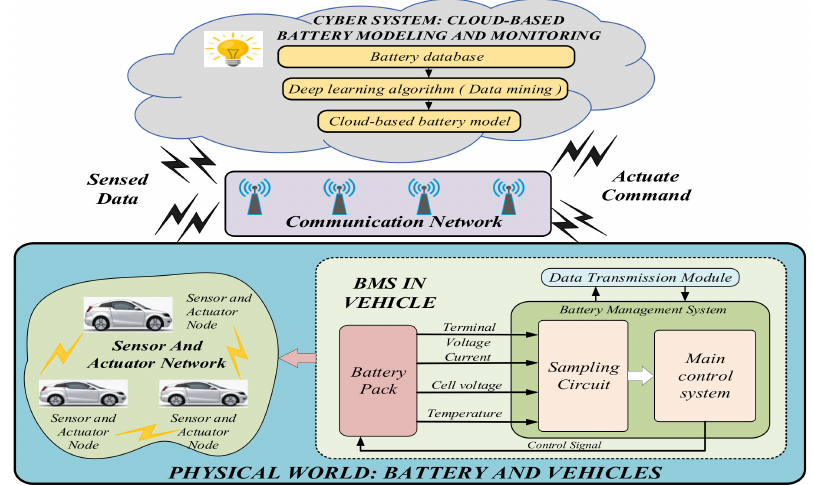
Figure 9. The DL and related method application for the SOH